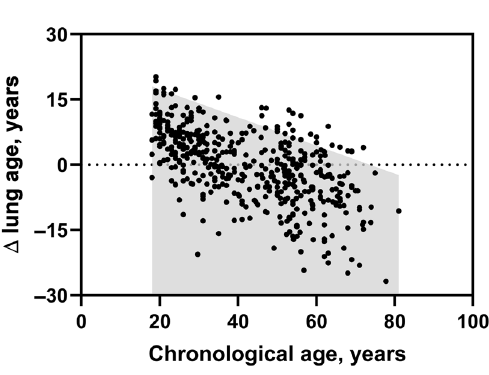
Fig. 3 Δ lung age of healthy subjects in the validation group. The grey area represents the upper limit of normal of the Δ lung age.